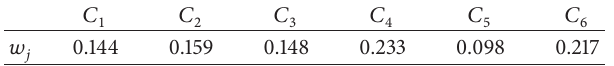
Table 11: Normalized scores.